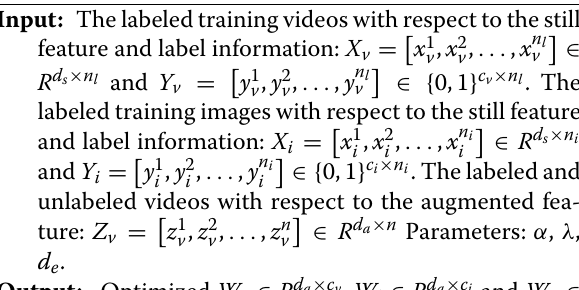
Algorithm 1 Jointing Cross-media Analysis and Embed- ded